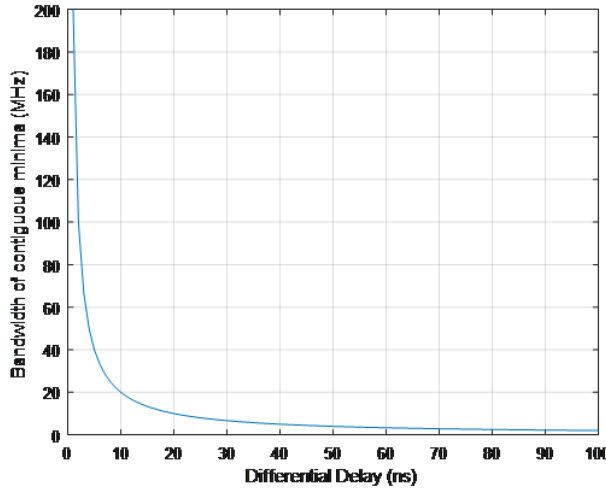
Figure 6. Bandwidth in MHz at minima for a two-ray